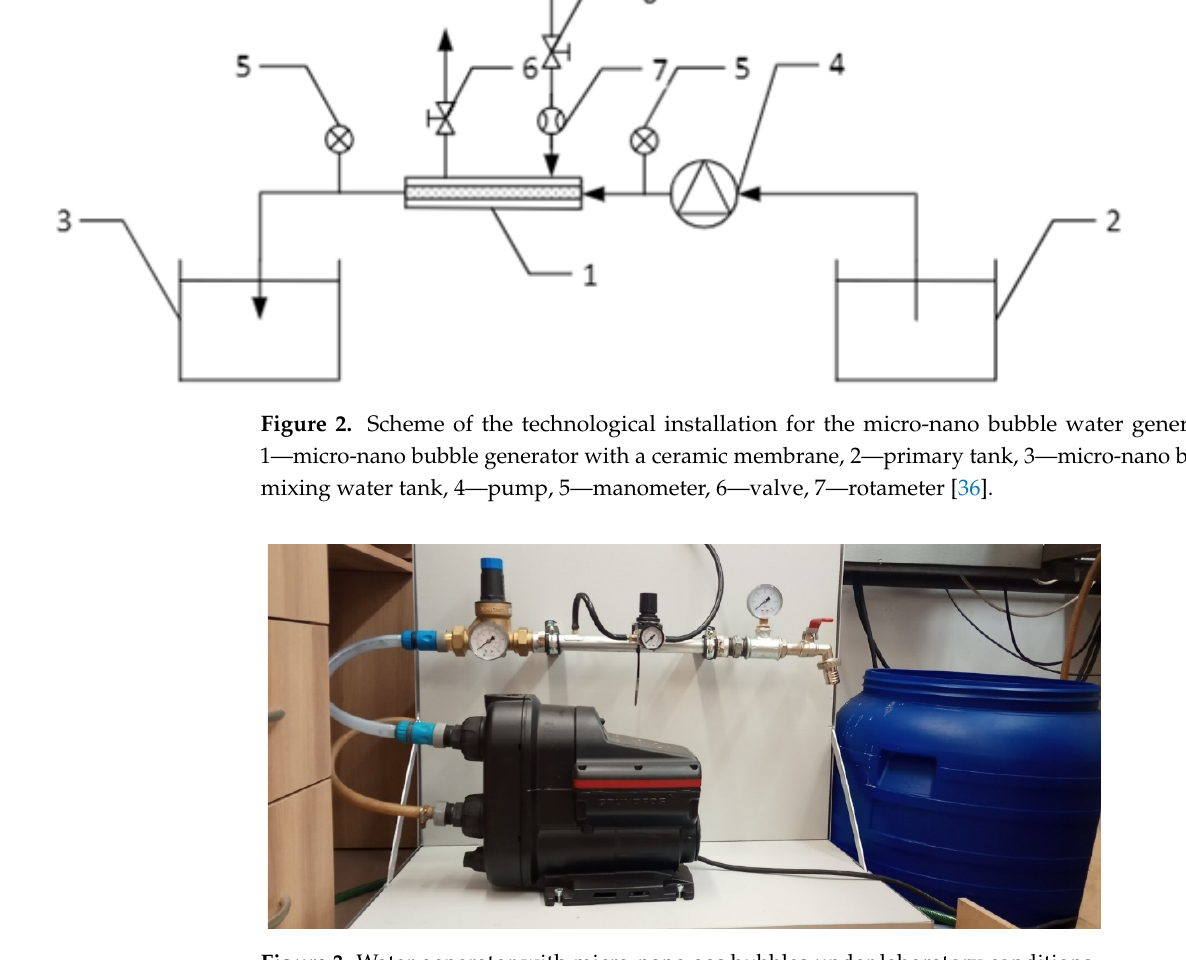
Figure 3. Water generator with micro-nano gas bubbles under laboratory conditions.